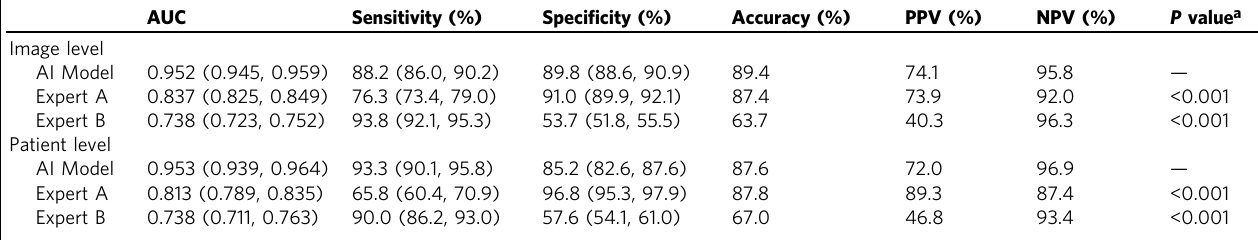
Table 1 The diagnostic performance of the ensembled deep learning model (in a cross-validation manner) and two human experts on the internal